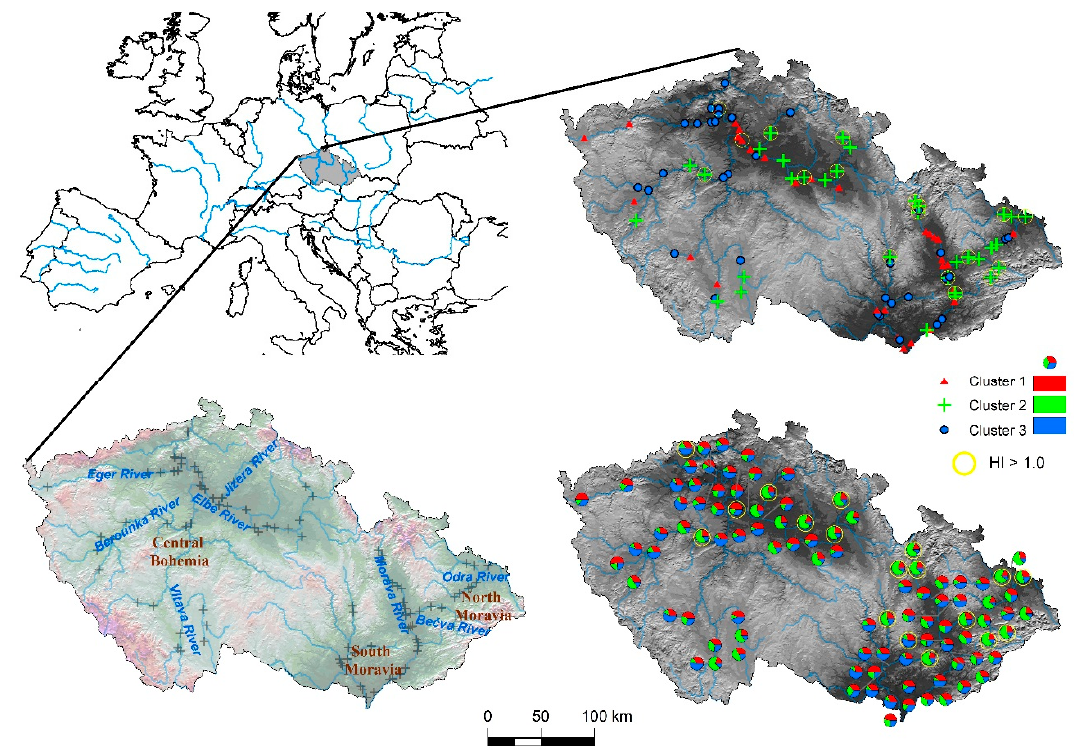
Figure 5. Membership probabilities and assigned cluster number in a geographical representation for regional interpretation (note that the samples with HI HUMAN > 1.0 are highlighted with a yellow circle).